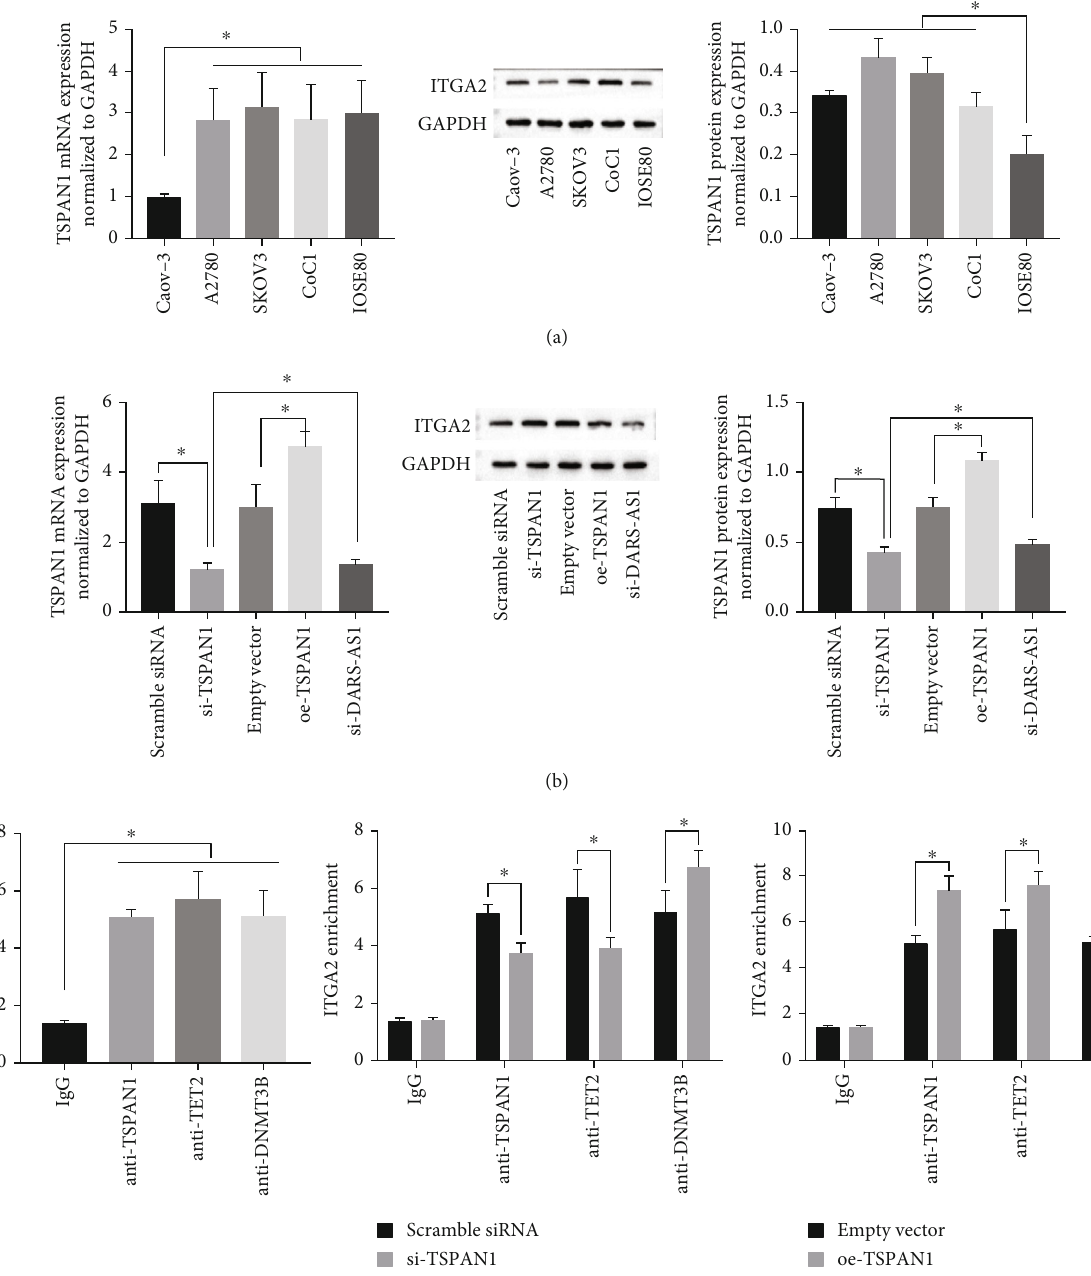
Figure 6: TSPAN1 mediates ITGA2 hypomethylation in OC cells. (a) qRT-PCR detection and western blotting of ITGA2 expressions in OC cell model and normal cells. (b) qRT-PCR detection and western blotting of ITGA2 expressions in A2780 cells following transfection with either si-DARS-AS1, si-TSPAN1, or oe-TSPAN1. (c) ChIP detection of ITGA2 enrichments in immunoprecipitates using anti-TSPAN1, anti-TET2, and anti-DNMT3B in A2780 cells after TSPAN1 knockdown or overexpression. A symbol of ∗ represents p < 0 : 05